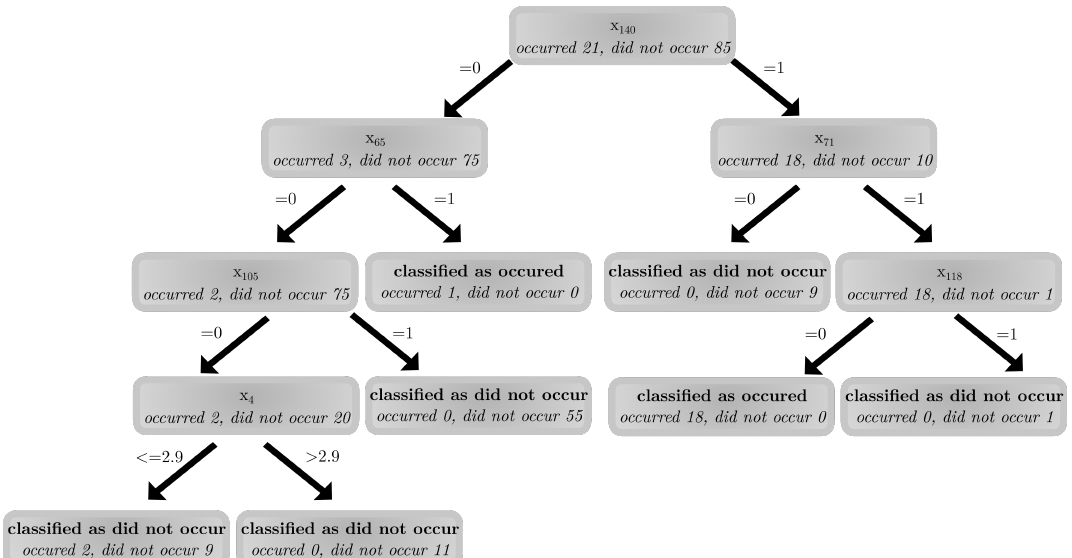
Figure 3. An example tree developed for the event e 19